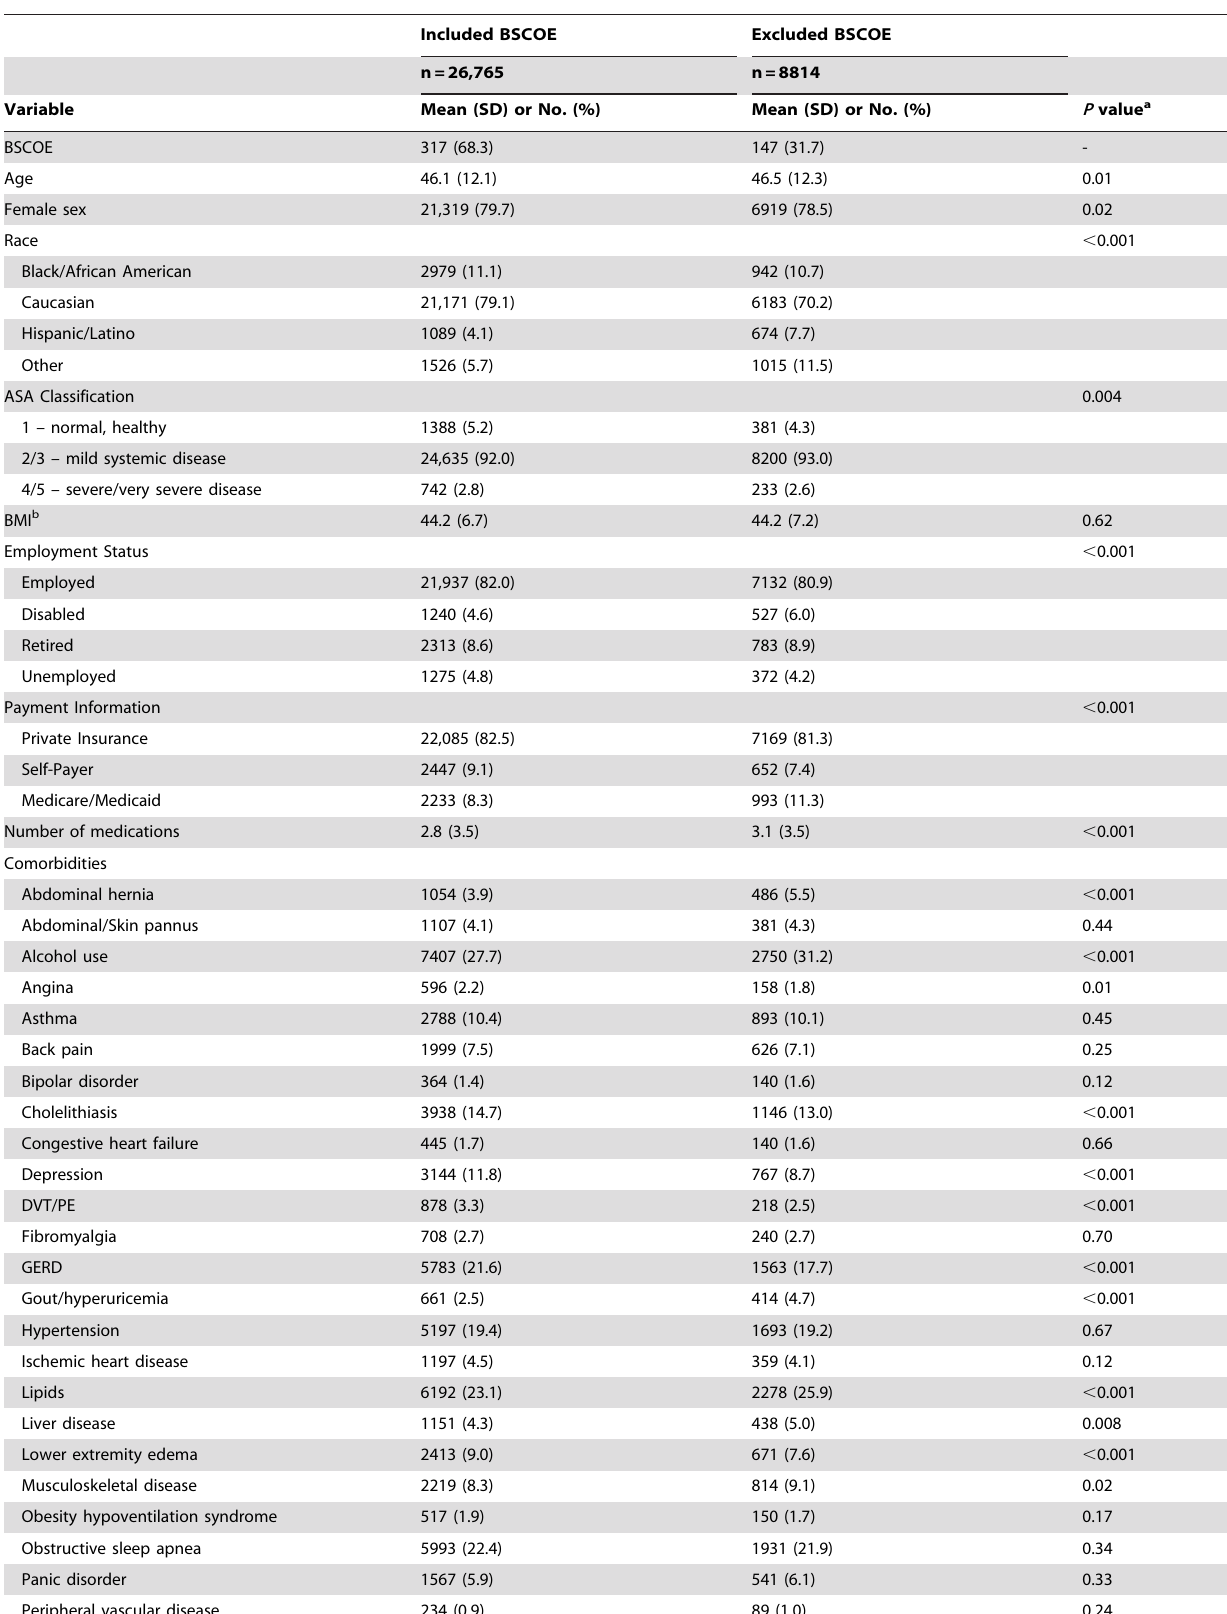
Table 6. Comparison of AGB Patients from Included and Excluded BSCOE.